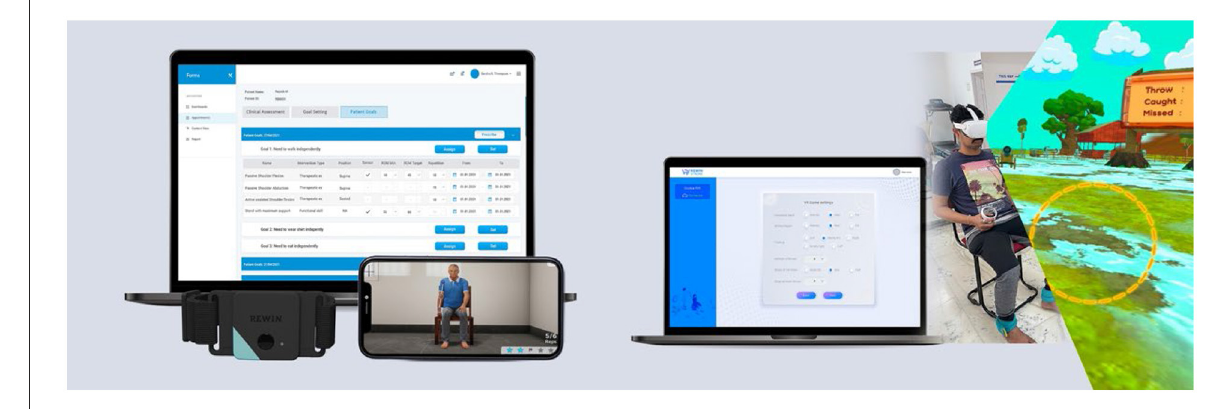
FIGURE1 The ReWin